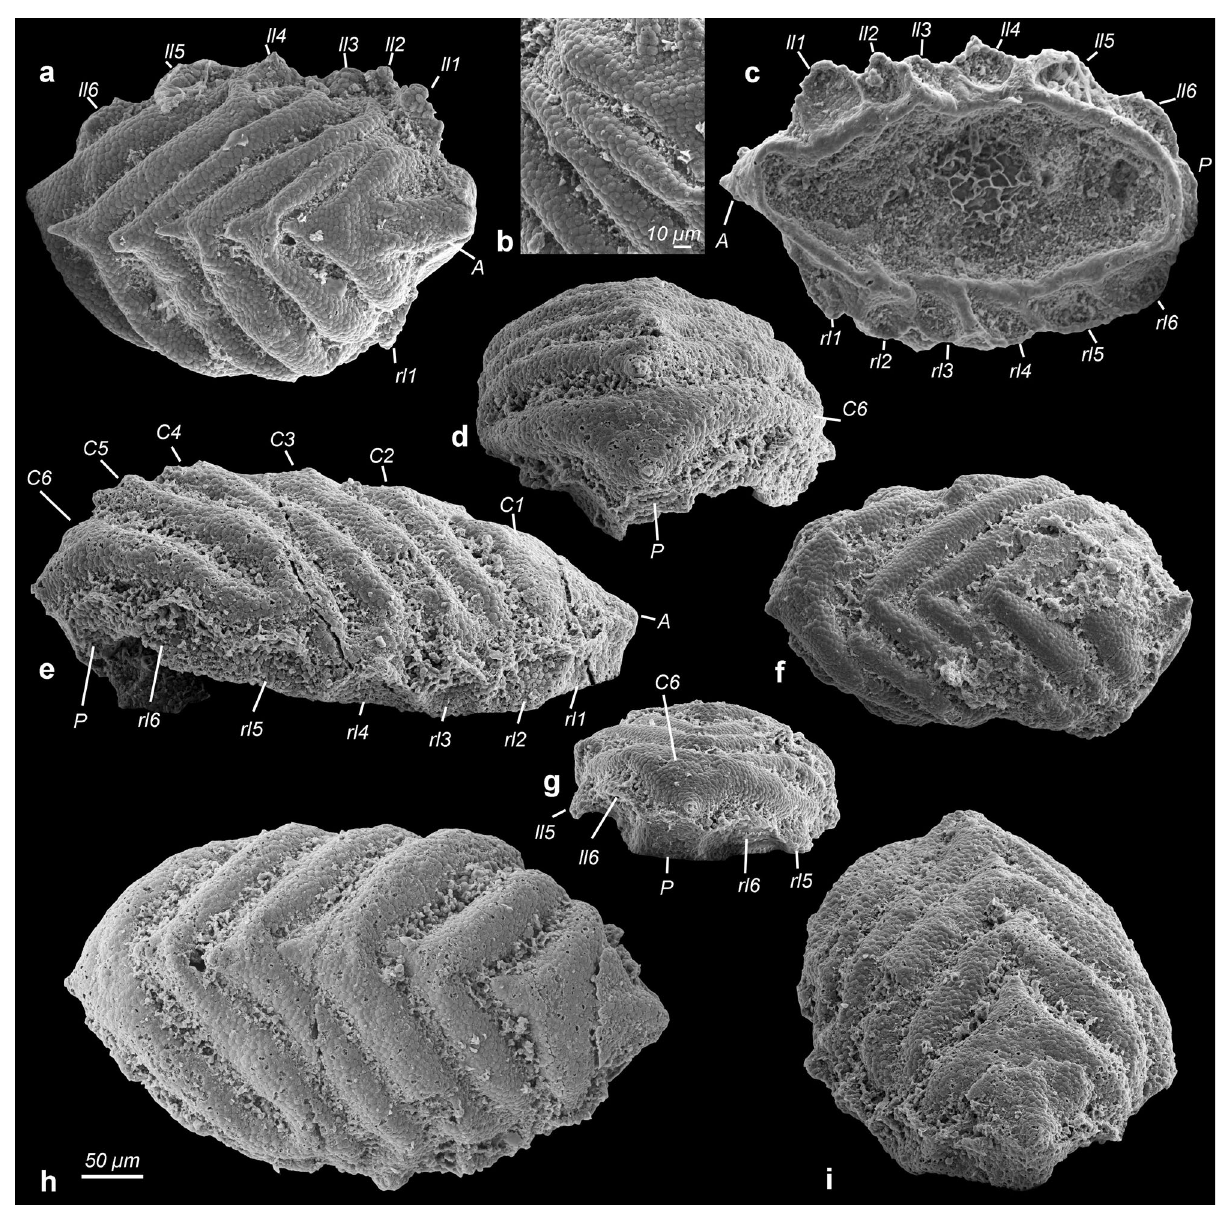
Fig. 3 Camenellan juveniles from the Cambrian Salanygol Formation of Mongolia. a Dorsal view of an early juvenile with six arc-shaped ridges preserving cellular pattern; anterior nascent sclerite with different morphology. b Close-up of central ridges C1 – 3 with cellular pattern, enlargement of individual shown in a . c Ventral view of the early juvenile shown in a , with six pairs of lateral protuberances. d Posterior view, posterior nascent sclerite forms a small fi eld only in this ontogenetic stage. e Lateral view on right peripheral zone with six small lateral protuberances. f Dorsal view of an individual with shallow central ridges. g Posterior view, note left lateral nascent sclerite fi ve forms an asymmetric cone. h Dorsal view of an early juvenile with six arc-shaped central ridges. i Anterior view of h showing anterior nascent sclerite developing a different morphology than central nascent sclerites 1 – 6. C1 – 6 central nascent sclerite 1 – 6 of medial zone, P posterior nascent sclerite, A anterior nascent sclerite, ll1 – 6 left lateral sclerites 1 – 6 of peripheral zone, rl1 – 6 right lateral nascent sclerites 1 – 6 of peripheral zone. All images are electron microscope micrographs, all images at same scale except for b . Specimen identi fi